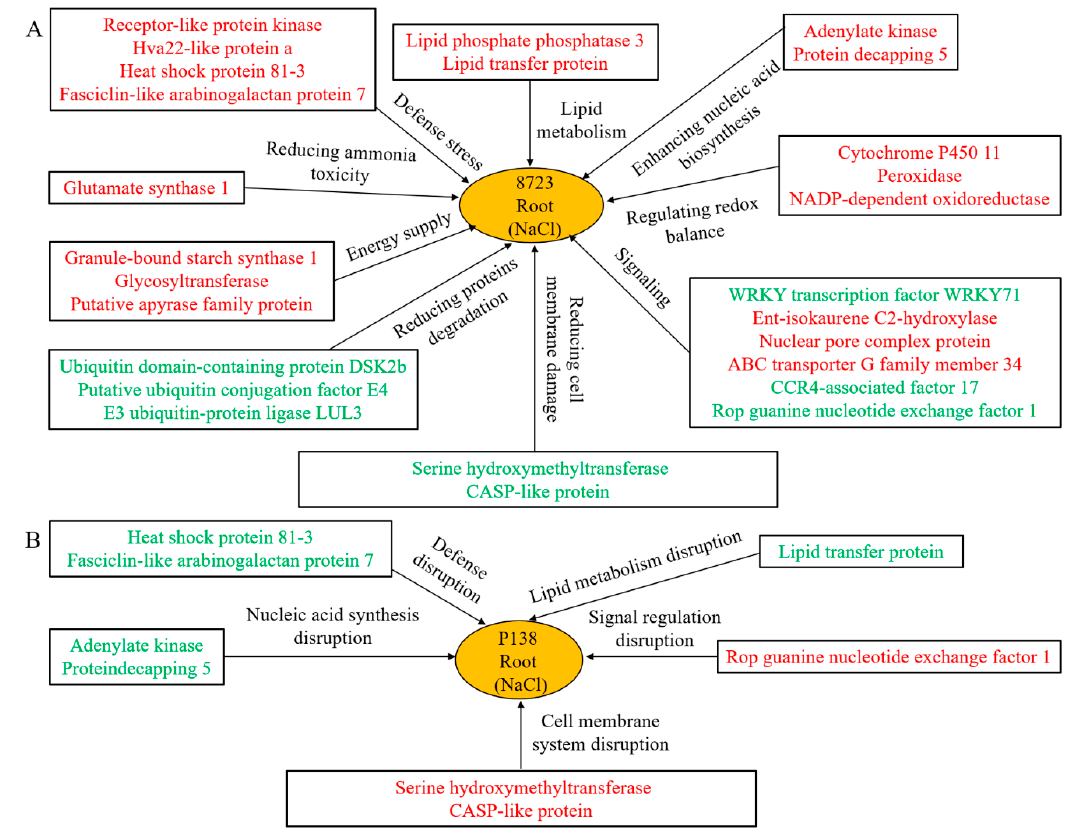
Figure 8. Molecular models of salt tolerance in maize seedling roots of: ( A ) tolerant inbred line 8723 and ( B ) sensitive line P138. The red font represents the up-regulated proteins, and the green represents the down-regulated proteins.